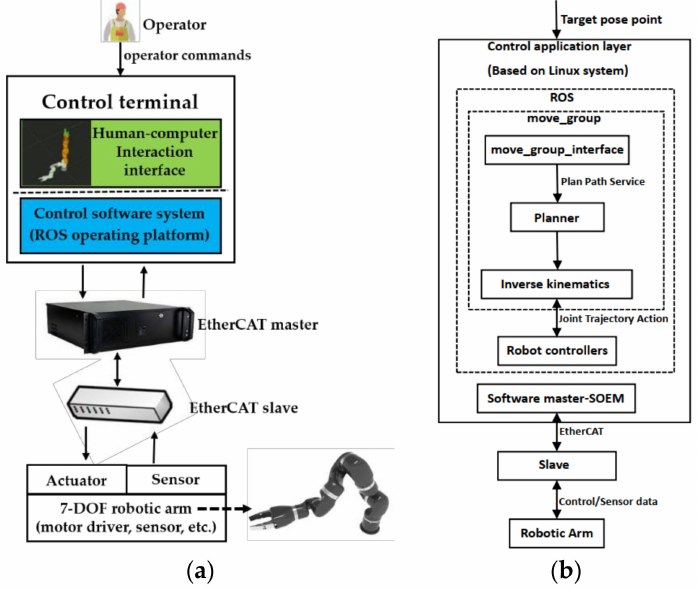
Figure 4. ( a ) The robotic arm operating system component. ( b ) Control software